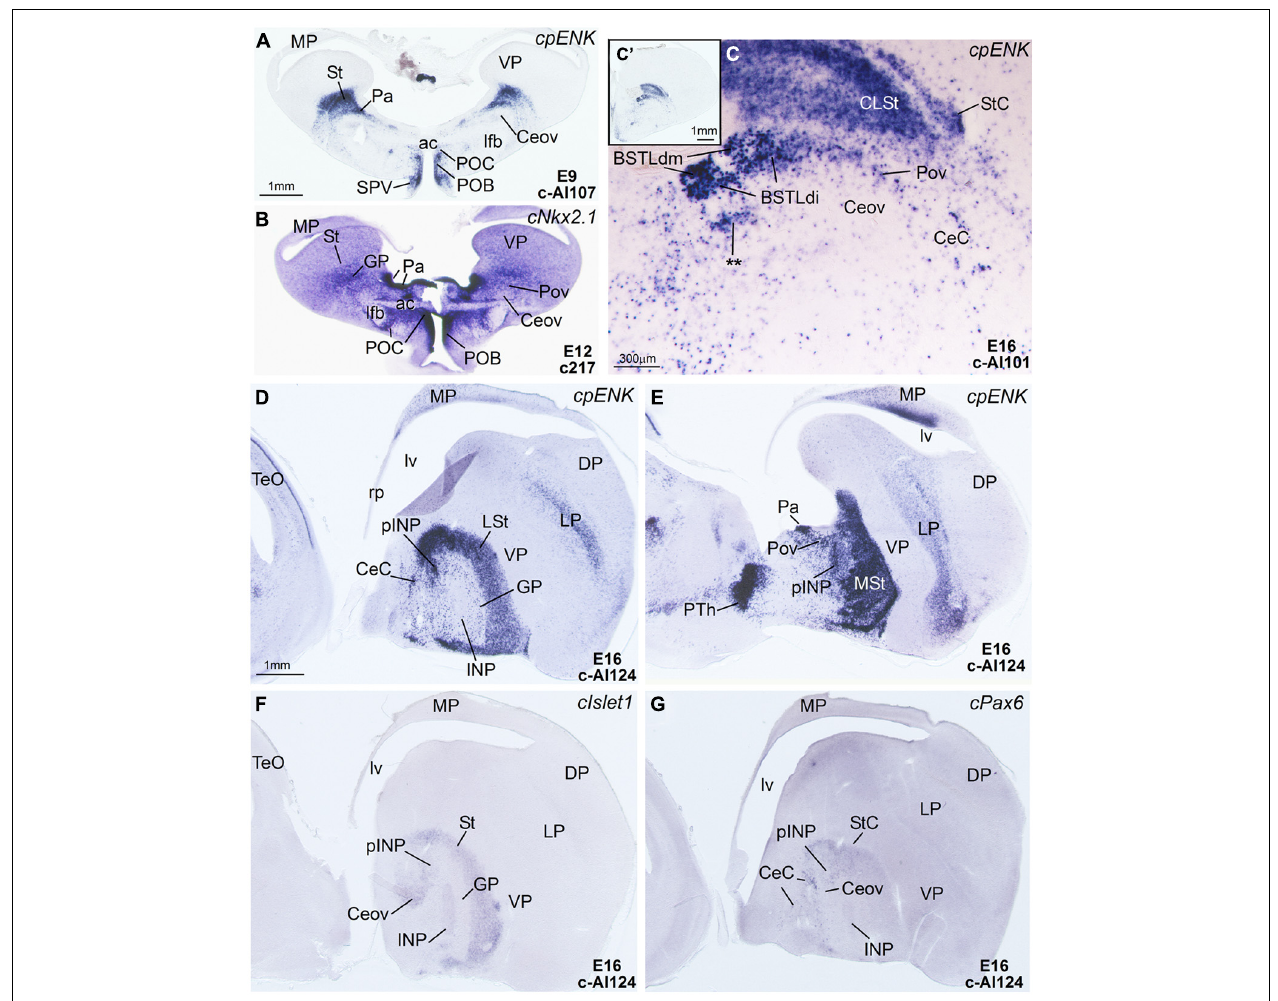
cpENK and cNkx2.1 in the BSTLd and the Pov, and the continuity between both structures. See text for more details. The double asterisk in (C) is showing a cpENK -expressing cell group different from those found in the medial, intermediate or lateral BSTLd subdivisions (BSTLdm, BSTLdi, BSTLdl). The embryonic origin of these cells is unclear. This cell group could be a different, ventrolateral subdivision within the BSTLd. For abbreviations, see list. Scale bars: A = 1 mm (applies to A,B,D–G ); C = 300 μ m; C (cid:3)(cid:3)(cid:3) = 1 mm.